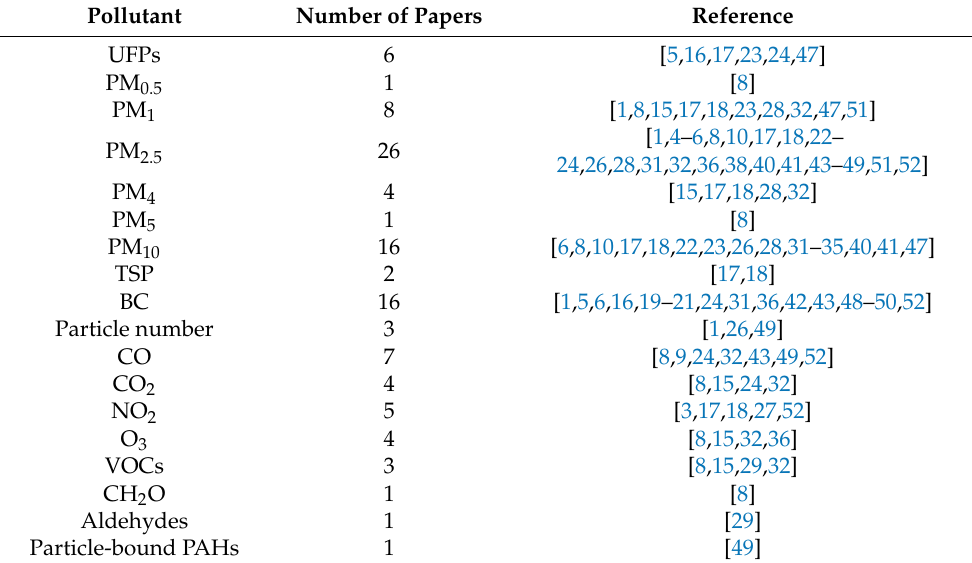
Table 2. Pollutants considered in the studies under review. UFPs: ultrafine particles (particle number); TSP: total suspended particles; BC: black carbon; VOCs: volatile organic compounds; PAHs: polycyclic aromatic